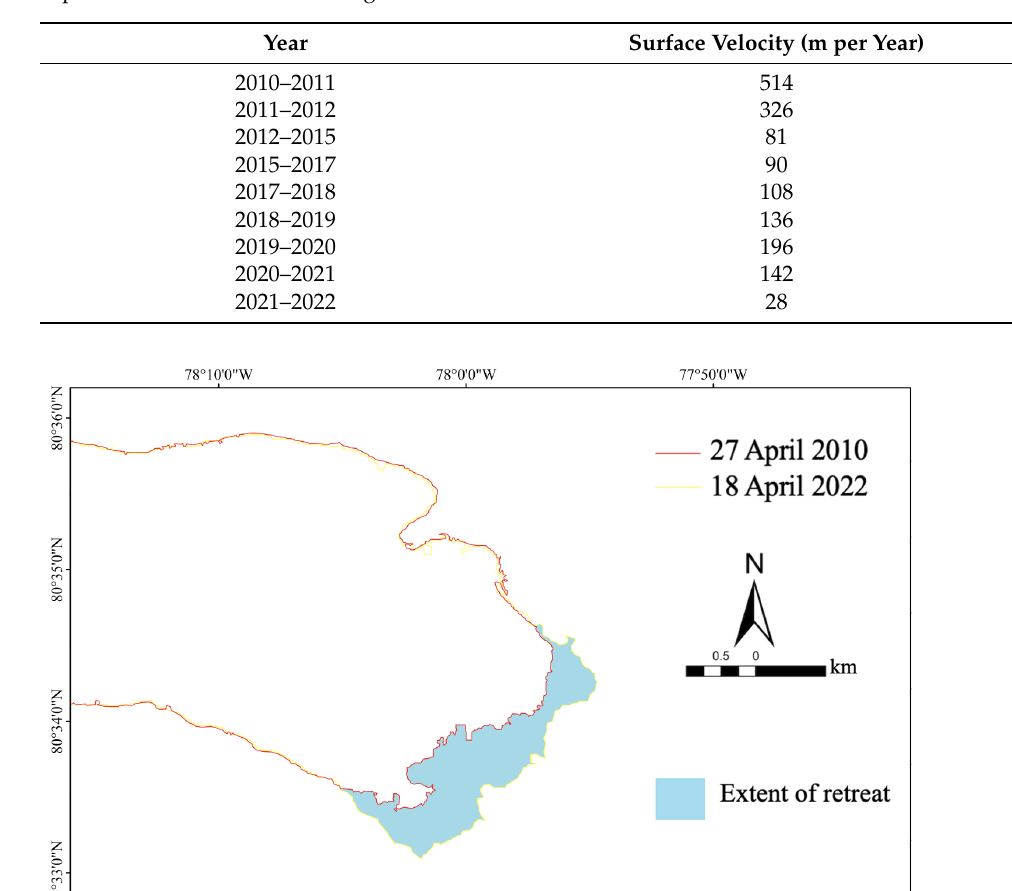
Figure 10. Estimation of the d’Iberville glacier retreat extent obtained from the ice fronts extracted in 2010 and 2022 from σ 0 HH